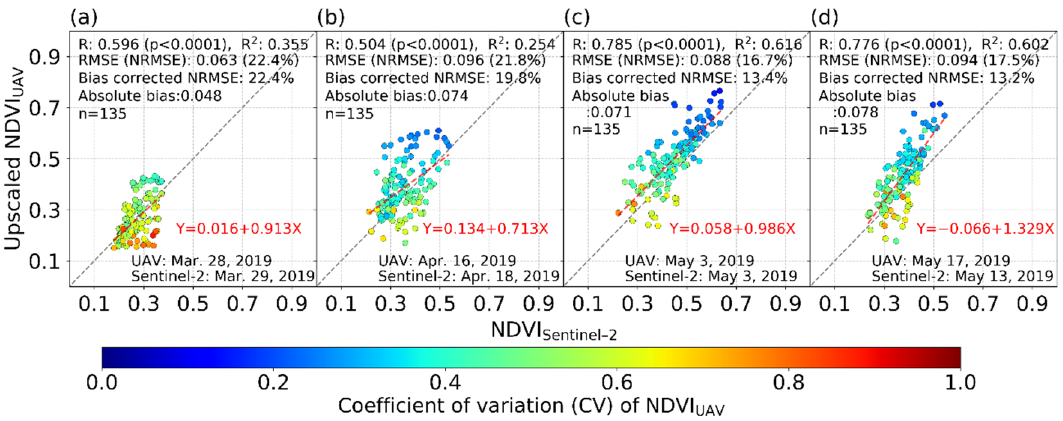
Figure 5. Relationship between upscaled NDVI UAV and NDVI Sentinel-2 on ( a ) 28 March 2019, ( b ) 16 April 2019, ( c ) 3 May 2019, and ( d ) 13 May 2019. NRMSE, normalized RMSE.